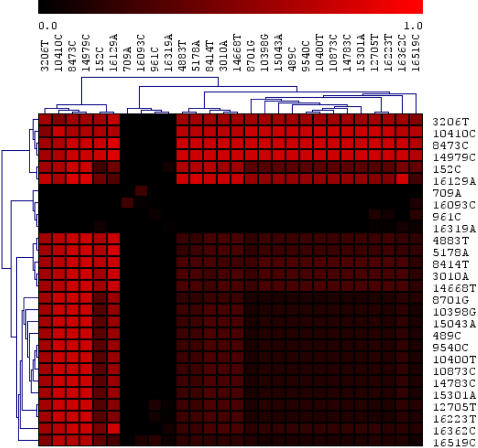
Heat map of the agreement matrix for SNPs across significant patterns.Note the presence of a group of 6 SNPs (upper left hand red box) strongly associated with longevity. These are: 3206T, 10410C, 8473C, 14979C, 152C and 16129A. The ones in bold are the same as in Figure 3 and are markers for D4a. The locations 152 and 16129 are known mutational hotspots in the hypervariable regions HVS-II and HVS-I respectively and hence their correlation with longevity cannot be considered significant.